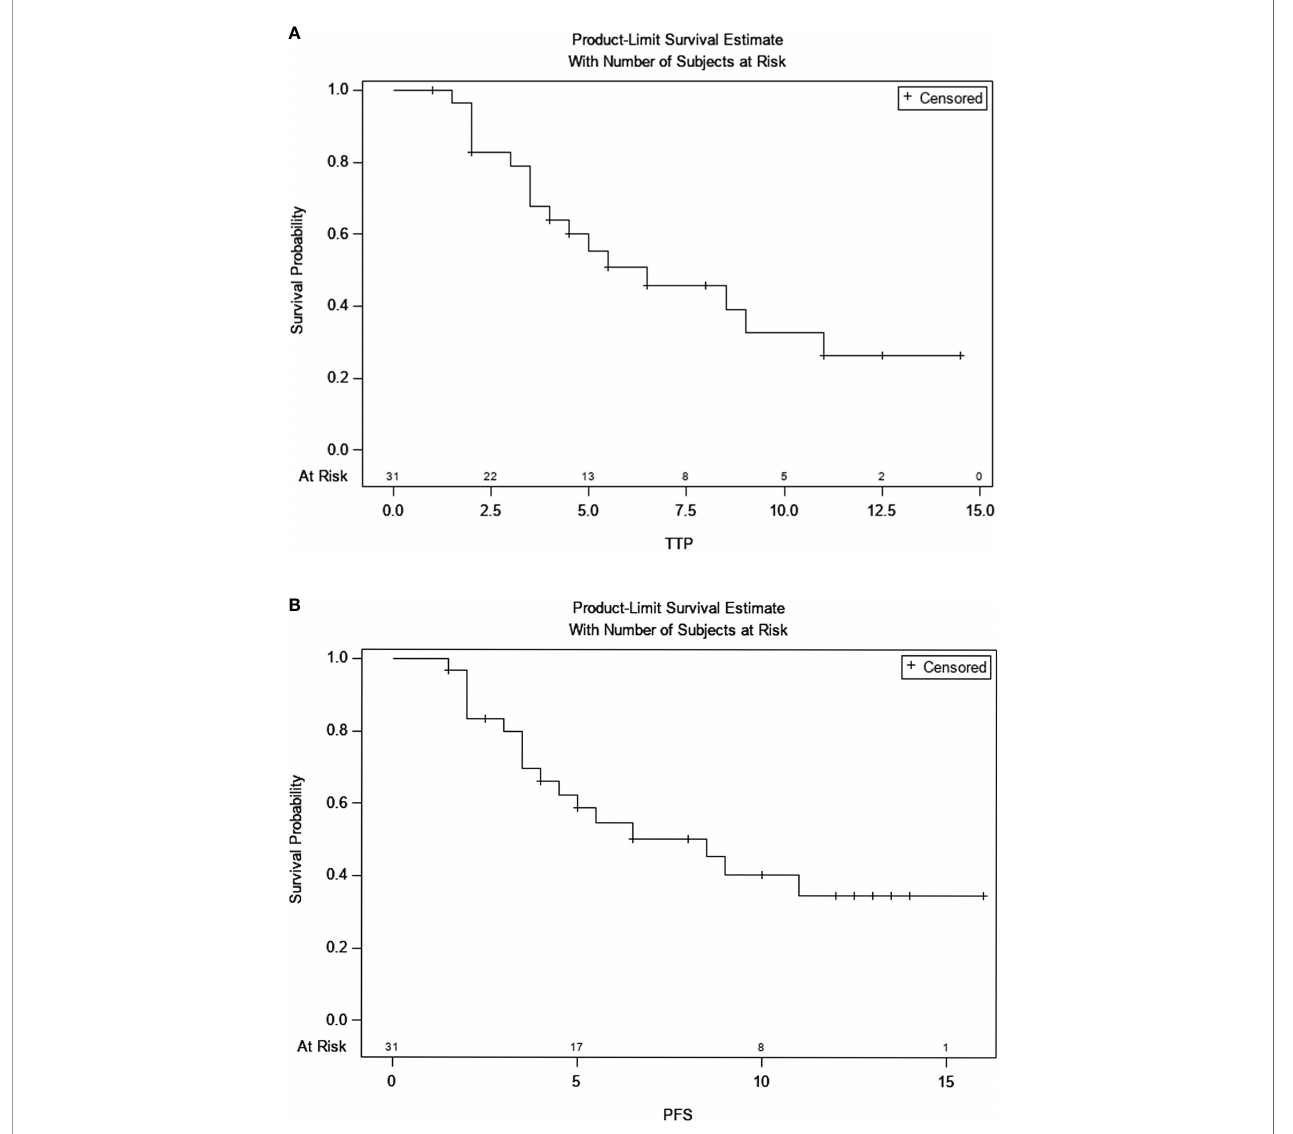
FIGURE 5 | (A) Kaplan-Meier curve of time to progression; (B) Kaplan-Meier curve of progression free survival.